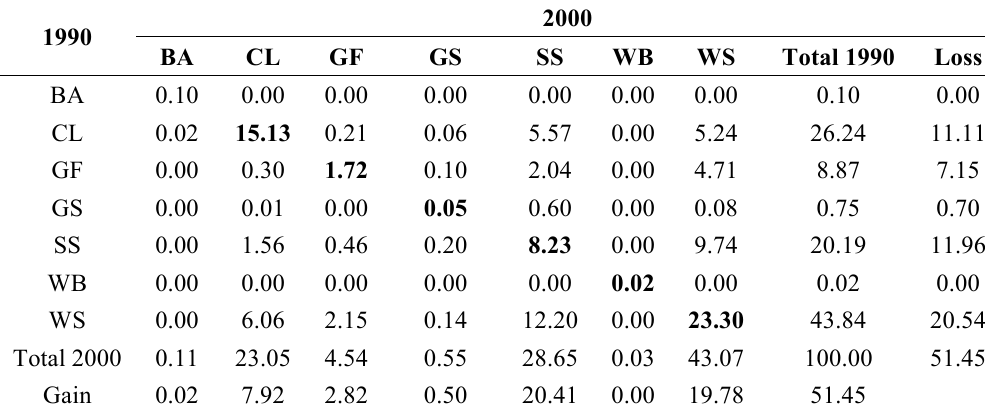
Table 6. Land cover change (%) matrix 2000–2013 in Cassou.